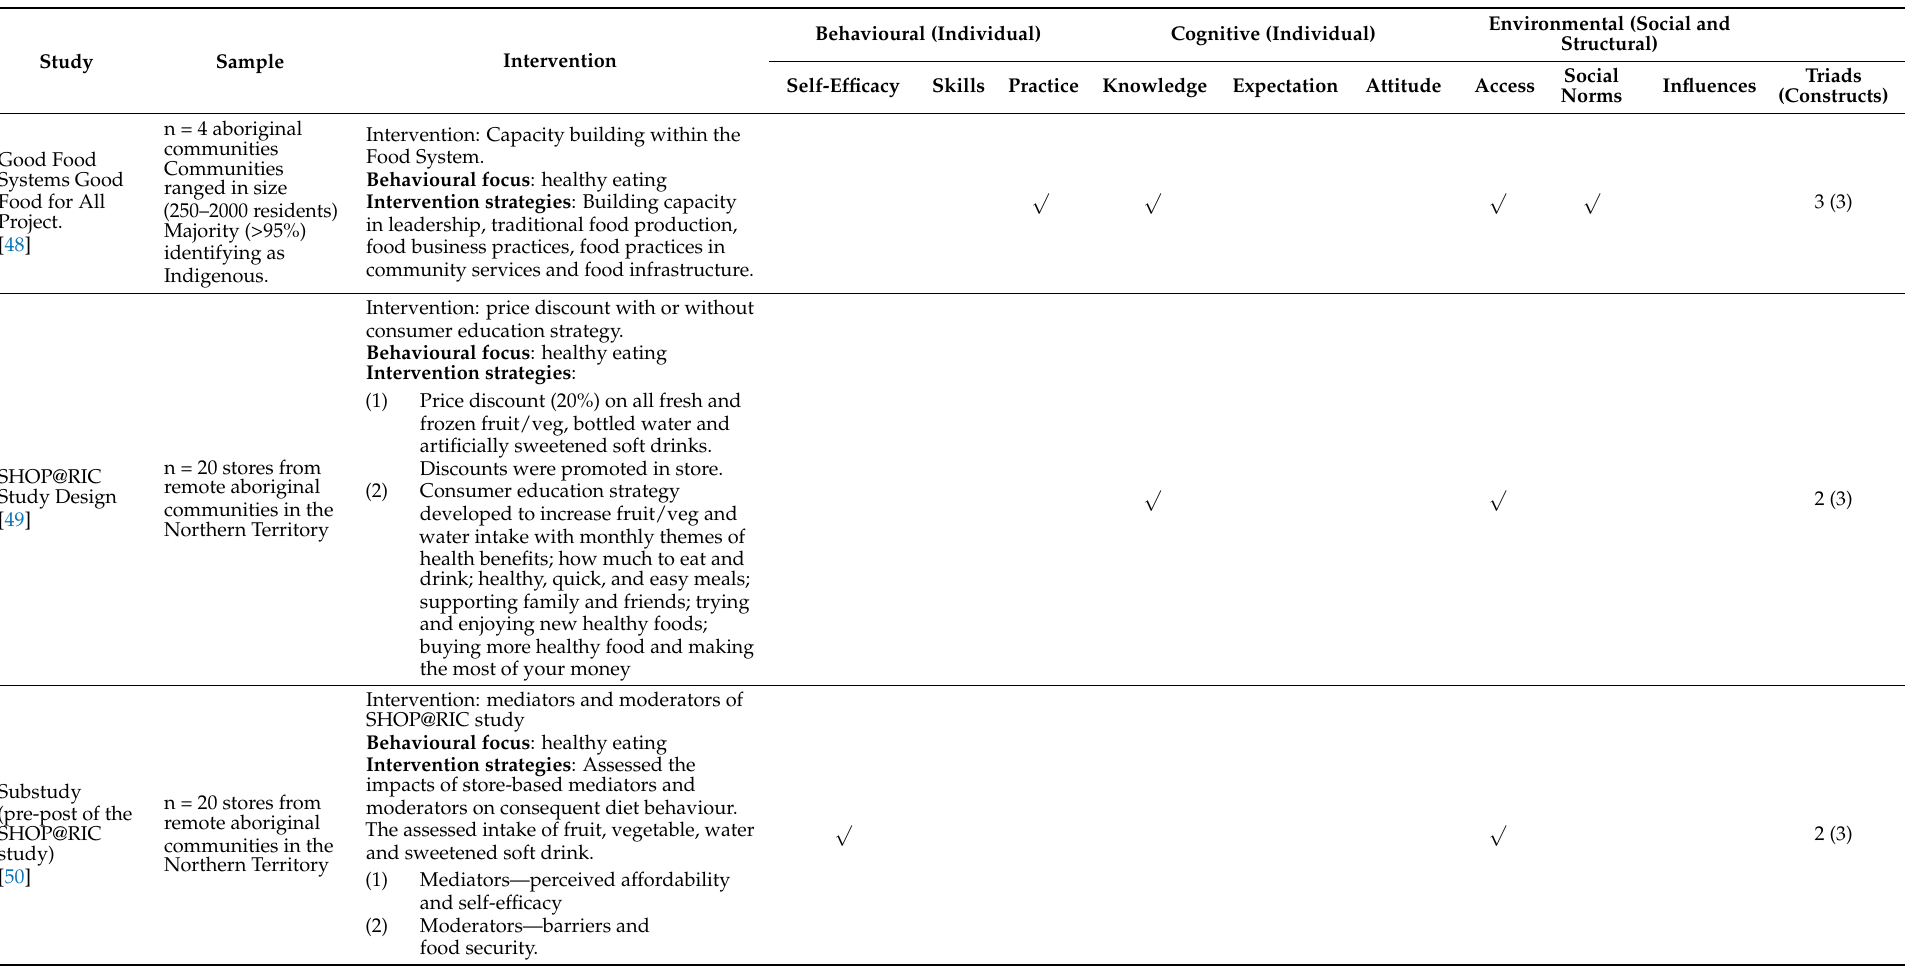
Table 1. Summary of healthy eating studies applying